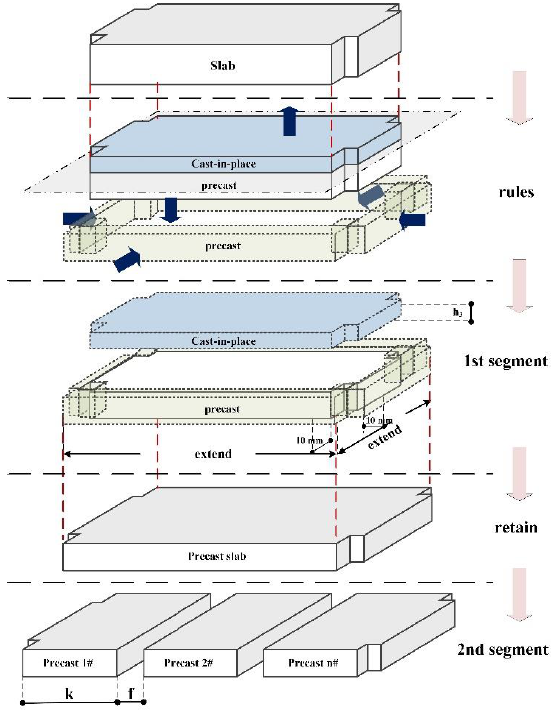
Figure 15. Segmentation of the slab model.